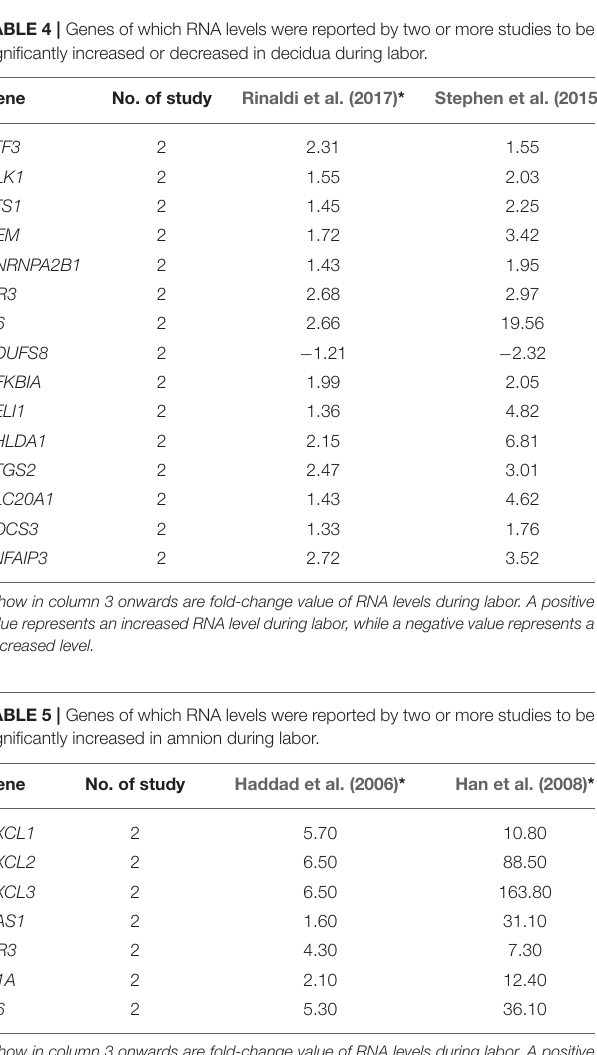
( Figure 2D , red dots). Enrichment analysis in g:Profiler showed the 7-gene list in amnion was enriched in 224 biological processes, including immune cell migration and response to cytokine/chemokine, ( Supplementary Material 7 ) and 27 pathways ( Figure 2D , blue dots). Five pathways, TNF, NOD-like receptor, legionellosis, cytokine-cytokine receptor interaction, and chemokine signaling pathways, were identified by both DAVID and g:Profiler ( Figure 2